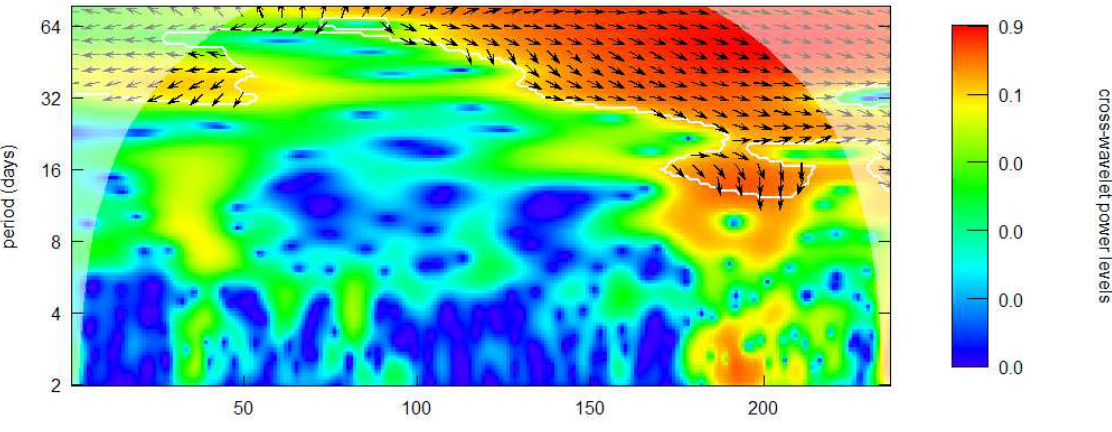
Figure 2. London Stock Exchange and NASDAQ